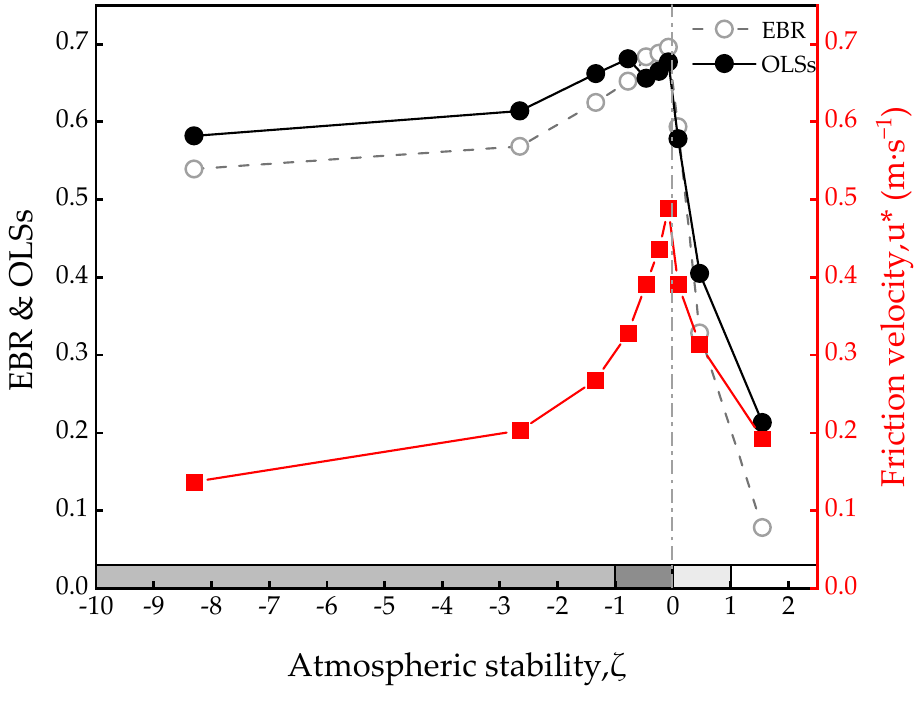
Figure 8. Effect of the atmospheric stability ζ on the surface energy closure fraction (including EBR and OLSs) and friction velocity u* during the daytime. The circles indicate the EBR values, the dots indicate the slope of the linear regression, and the squares indicate u*. The different colors at the bottom indicate the five categories of atmospheric stability, with gray being very unstable, dark gray being unstable, black being neutral (the range is too small to be easily seen in the figure), ash gray being stable, and white being very stable. Table 1. Surface energy closure fraction (including EBR and OLSs) in response to friction velocity u* and atmospheric stability ζ for each season during the study